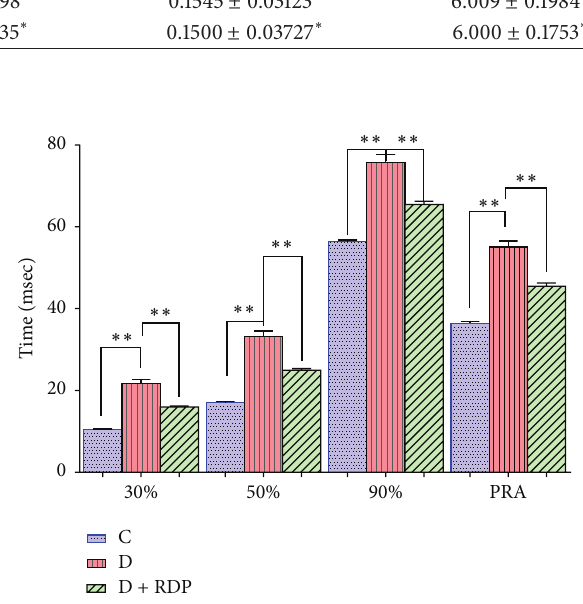
Figure 3: Mean values ± SEM of the quantified parameters of the action potentials recorded in the papillary muscles of the hearts of control rats ( 𝑛 = 225 ), diabetic rats ( 𝑛 = 110 ), and diabetic rats receiving apple peel for 90 days ( 𝑛 = 169 ) at a basic cycle of 500 milliseconds.Thesymbols( ∗∗ )indicatethatthedifferencesbetween the different groups are significant ( 𝑝 < 0.05